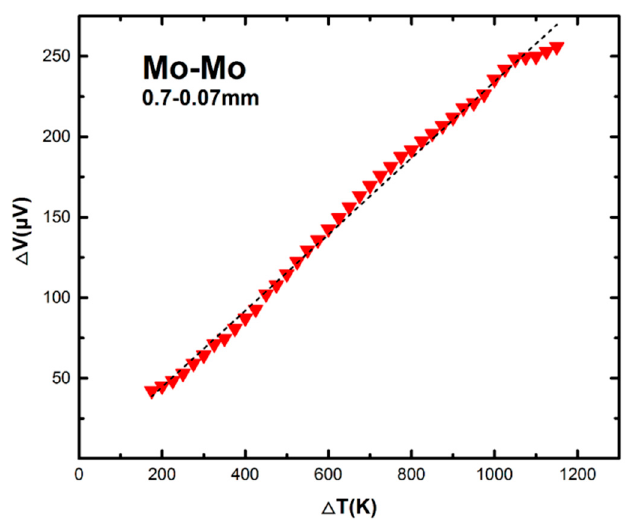
Figure 7. Measurement results for a sample made for two pieces of Mo wires with diameters of 0.07 mm and 0.7 mm, respectively. It shows a roughly linear response in the voltage output over a large temperature difference between the hot and cold ends up to 1200 K. Sensors 2017 , 17 , 331